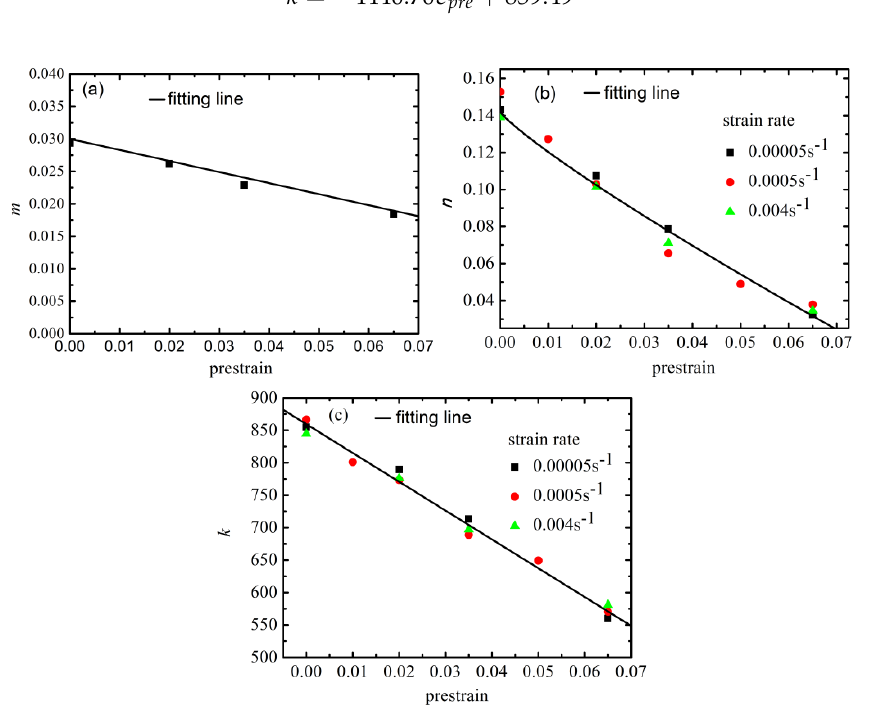
Figure 14. Variation of parameters with prestrain: ( a ) Strain rate sensitivity; ( b ) strain hardening exponent and ( c ) strength coefficient.